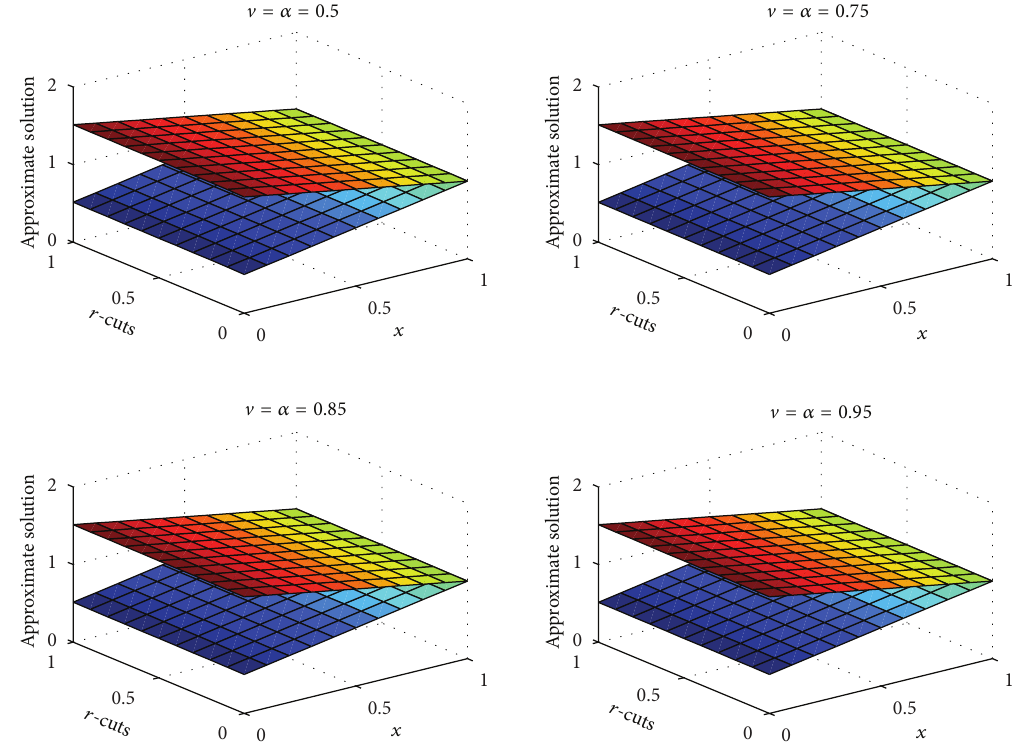
Figure 11: The fuzzy approximate solution for different values of fractional orders V = 𝛼 with 𝑚 = 12 , 𝑘 1 = 0.014 , and 𝑘 2 = 0.001 .